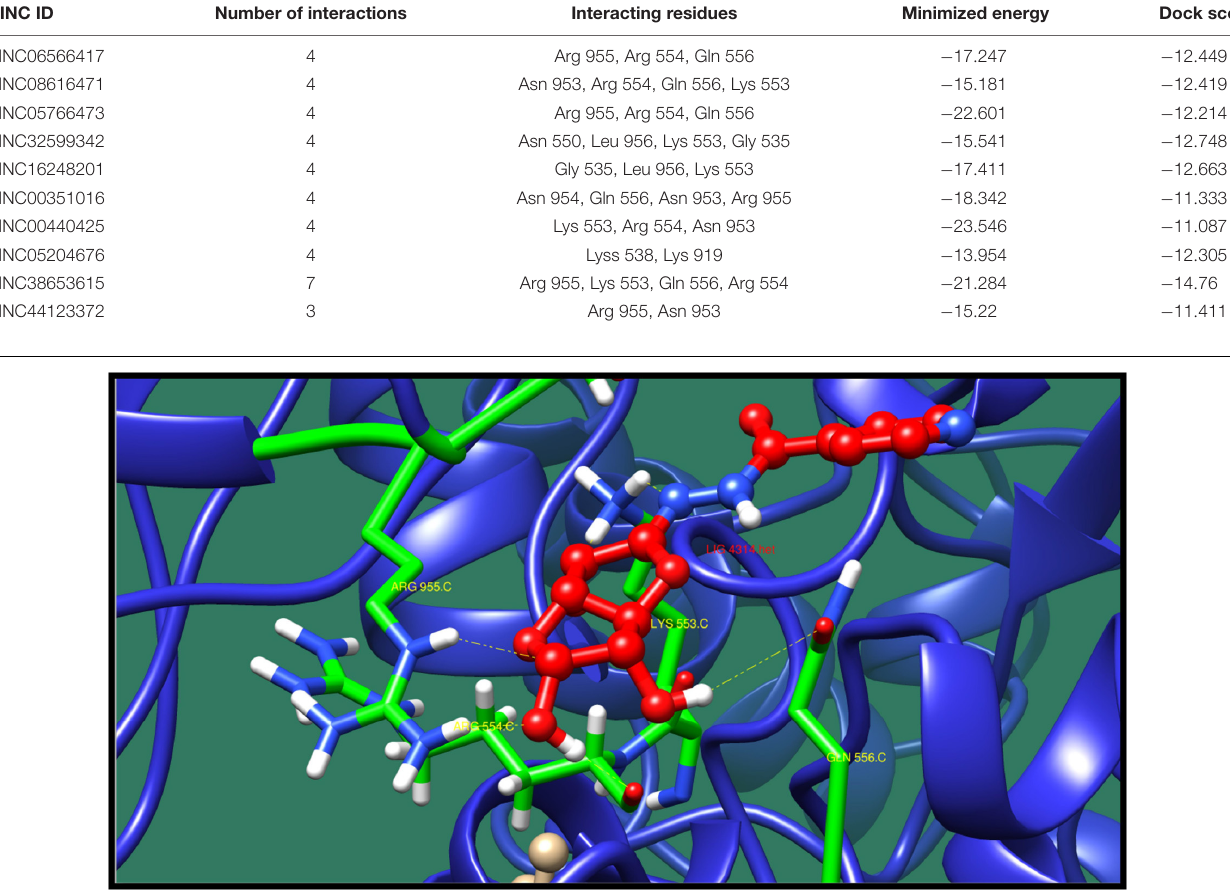
TABLE 12 | DNA polymerase III subunit alpha and its interaction profile with docked compounds, their ZINC ID, minimized energy, number of interactions, dock score, and interactive residues. ZINC ID